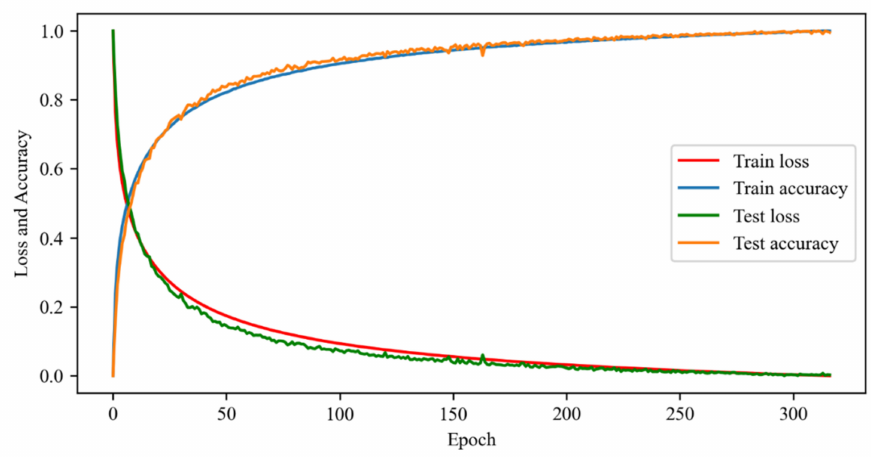
Figure 4. Loss and accuracy curve of proposed DNN architecture (SGDNet) for SGD